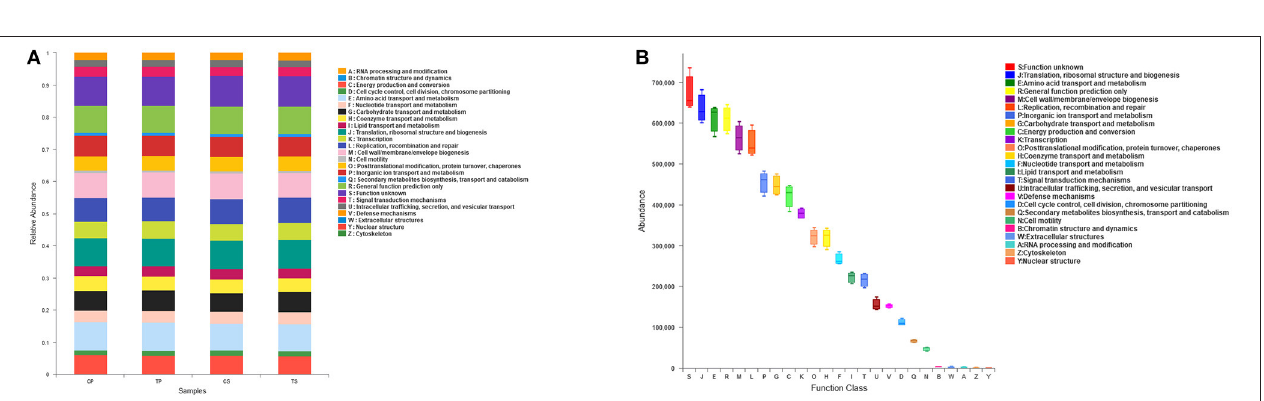
FIGURE 7 | Network analysis showed interactions of 20 richest genera (|SpearmanCoef| > 0.8 and P < 0.01). (A) Bacterial interactions in dental plaque. (B) Bacterial interactions in saliva. (C) Bacterial interactions of four different groups. The size of the node is proportional to the genera abundance. Node color corresponds to phylum taxonomic classification. Edge color represents positive (red) and negative (green) correlations.